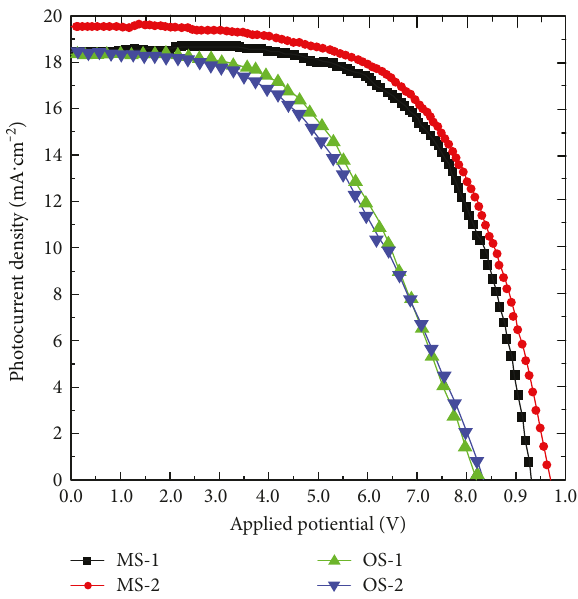
Figure 8: Top view SEM images of CH (a) MS slow and (c) OS direct annealing method. (b) and (d) are the enlarged images of the selected rectangular areas of (a) and (c), respectively.